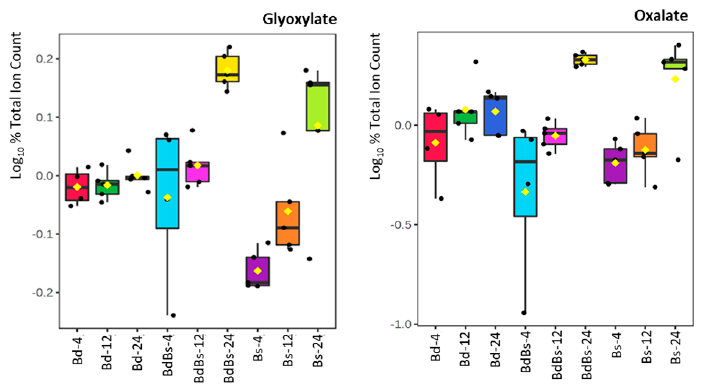
Figure 7. Oxalate metabolites in Brachypodium embryos during germination. Data show box and whisker comparison of B. distachyon Bd21 (Bd), B. stacei ABR114 (Bs), and B. hybridum ABR113 (BdBs) at 4, 12, and 24 HAI.